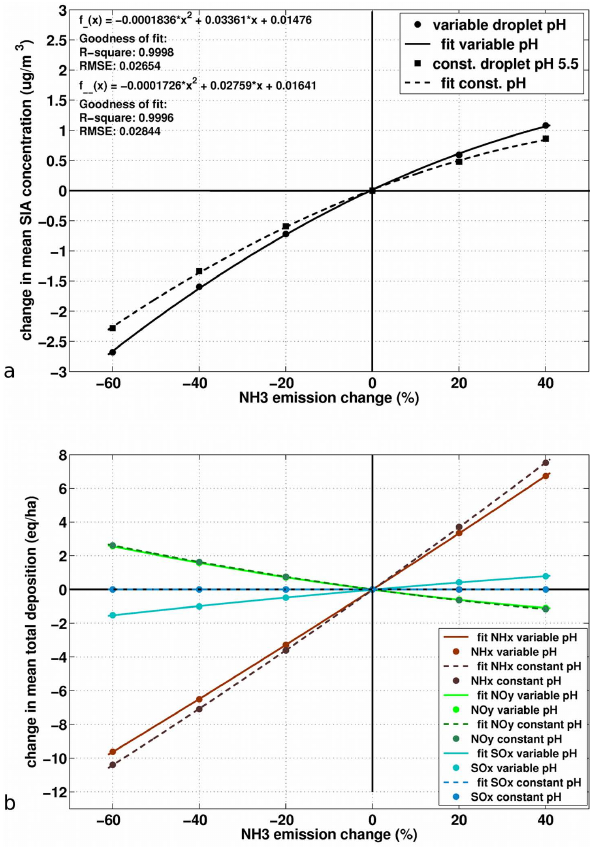
Fig. 12. Response of (a) the mean modelled SIA concentration and (b) the mean modelled SO x , NO y and NH x total deposition in the German domain to ammonia emission changes using a variable (solid line) or constant (dashed line) droplet